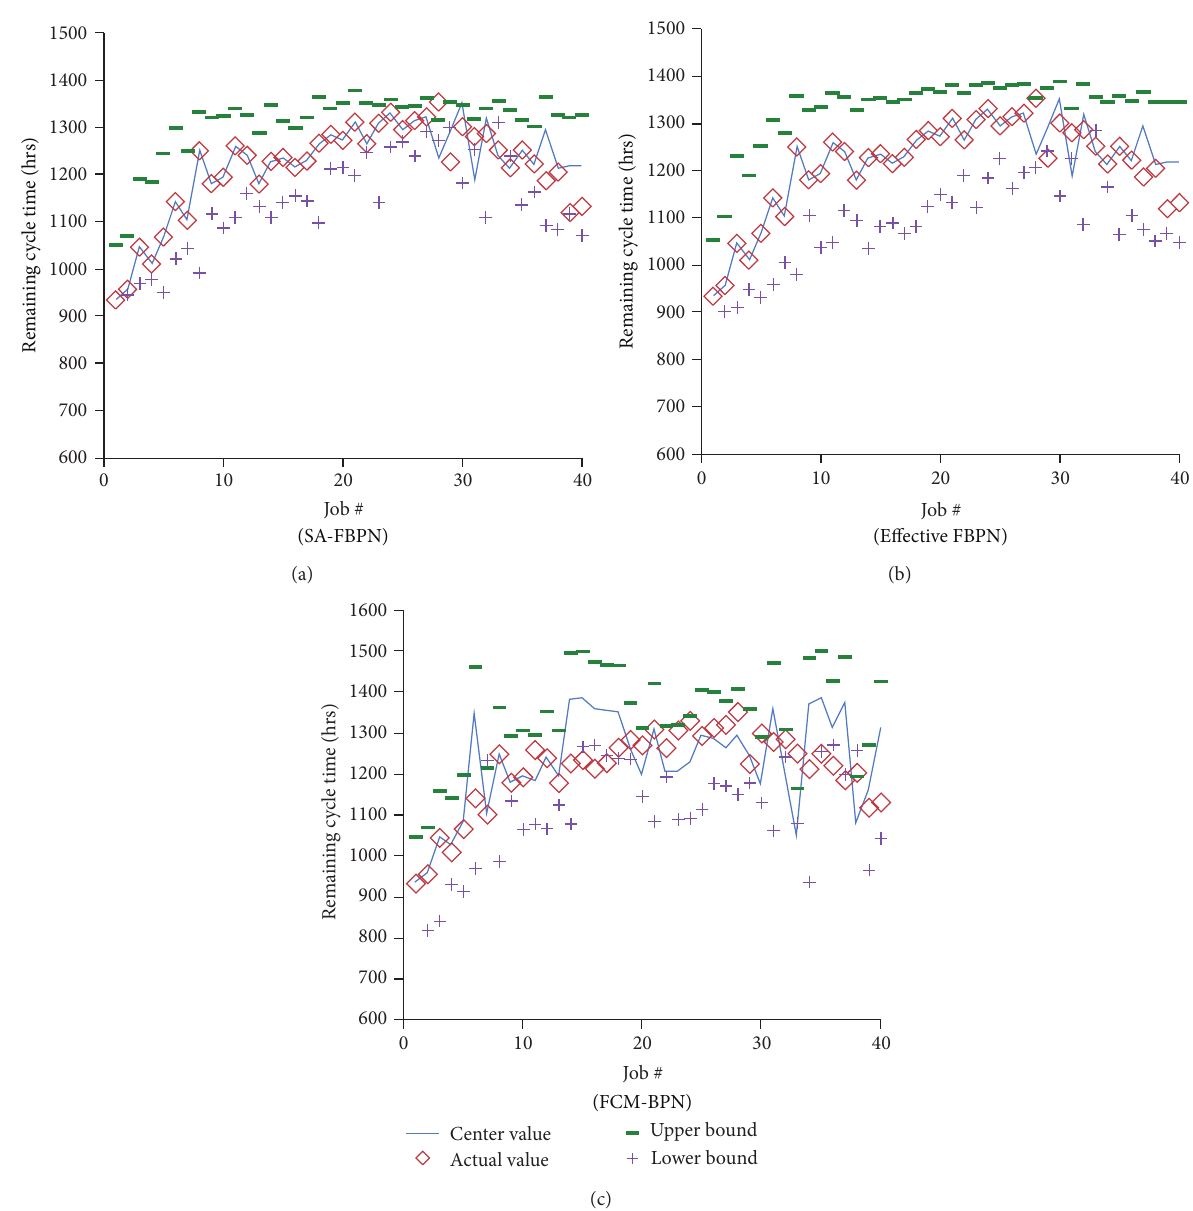
Figure 8: The performances of three approaches in estimating the remaining cycle time.